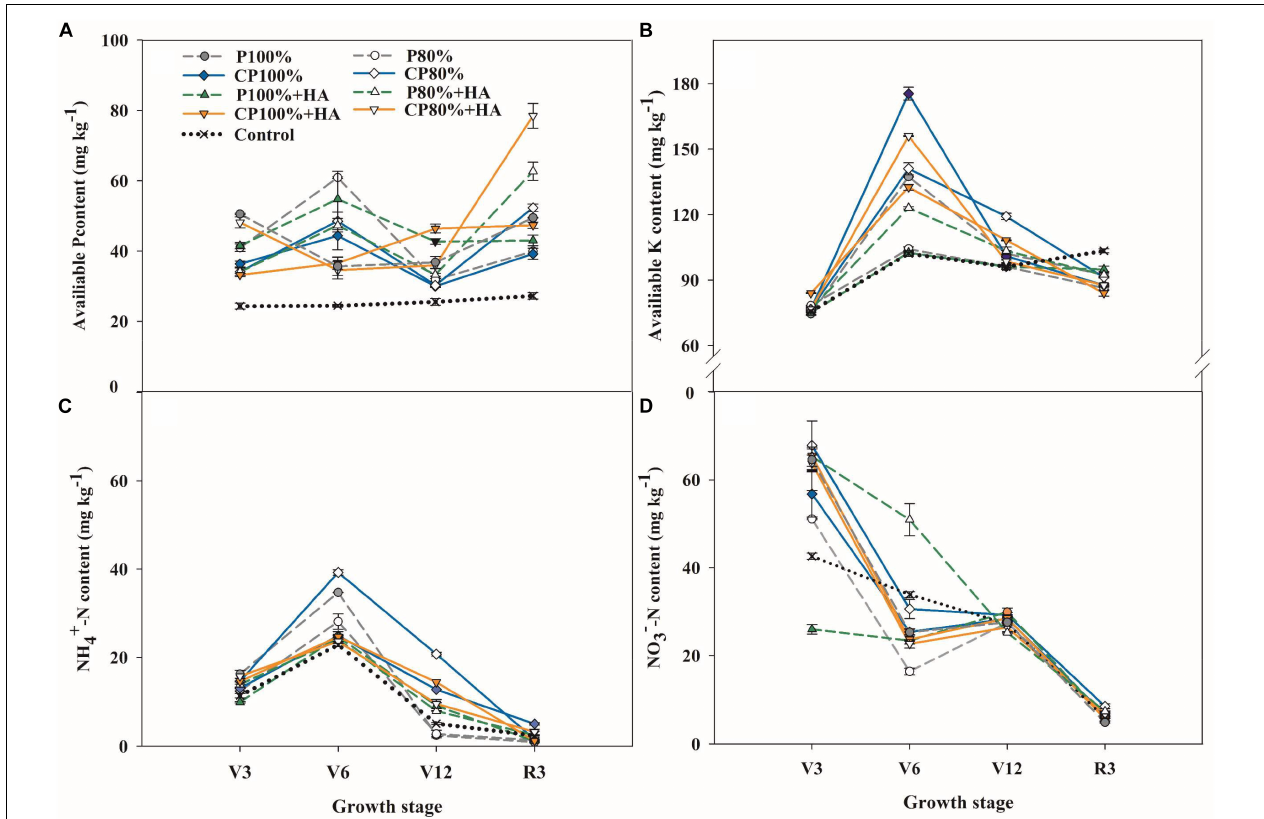
FIGURE 3 | Changes of soil available P (A) , available K (B) , NH 4 + -N (C) , and NO 3 − -N (D) contents in different fertilization treatments. Control, no P fertilizer added; P 100%, diammonium phosphate (DAP) at 75 kg P 2 O 5 ha − 1 ; P80%, DAP at 60 kg P 2 O 5 ha − 1 ; CP 100%, coated DAP (CDAP) at 75 kg P 2 O 5 ha − 1 ; C